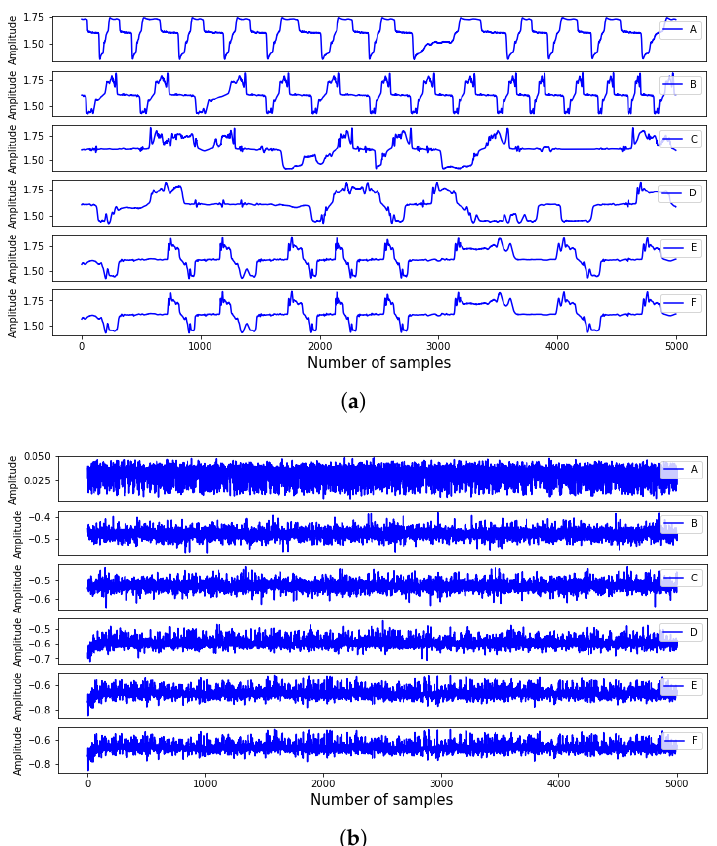
Figure 5. Experimental data at the various conditions ( a ) voltage signals. ( b ) current